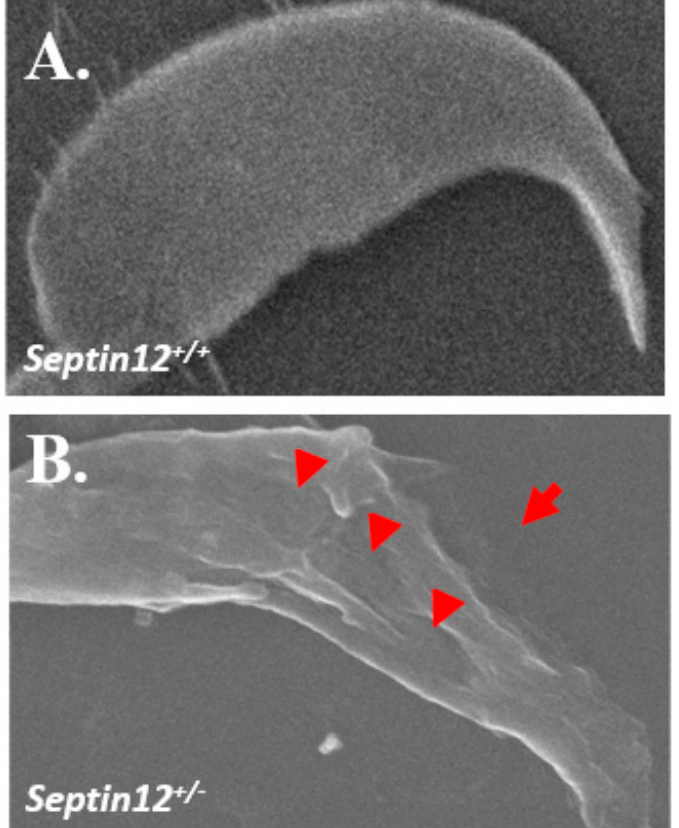
Figure 1. Spermatozoa from Septin12 knockout mice with abnormal head shapes. Scanning electron microscopy (SEM) images of sperm cells isolated from ( A ) Septin12 +/+ and ( B ) Septin12 +/ − mice. Arrowheads indicate abnormalities on the outside membrane of the sperm head. The arrow indicates the disrupted acrosome (Magnification: ×3000).